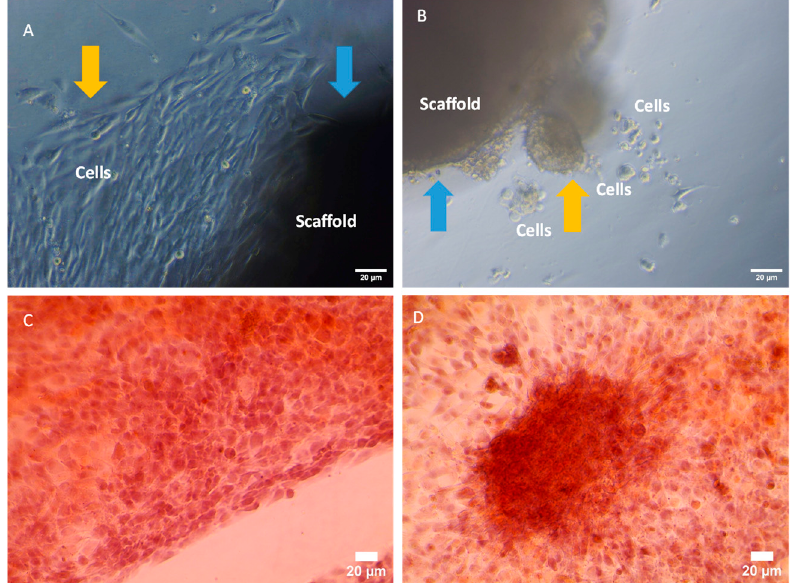
Figure 7. ( A , B ) Live images of cell migration from cryogel sca ff olds after 7 day culture; ( C , D ) Aliz- arin Red staining images of the migrated cells after 11 day culture. ( A ) 100:0 0B, ( B ) 100:0 3B, ( C ) 100:0 0B, ( D ) 100:0 3B. Blue arrows indicate sca ff olds; yellow arrows indicate migrated cells.